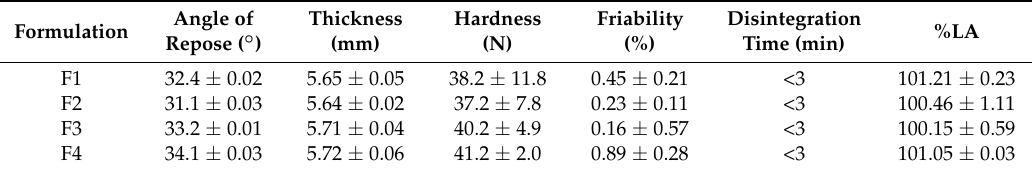
Table 4. Properties and assay results for the albendazole SMEDDS chewable granules and tablets (F1–F4) (mean ± SD, n = 10).